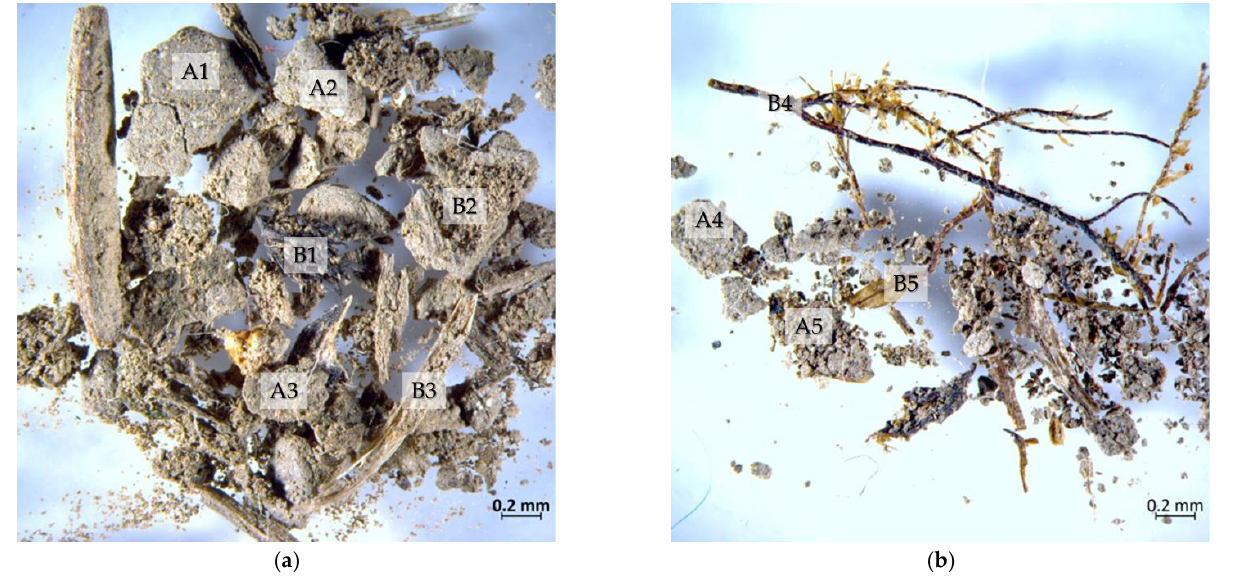
Figure 6. Photo of 1 – 0.5 mm fraction: ( a ) August 2016; ( b ) June 2021. A1 – A5 — terrigenous fragments of minerals d; B1 – B5 — wood debris.